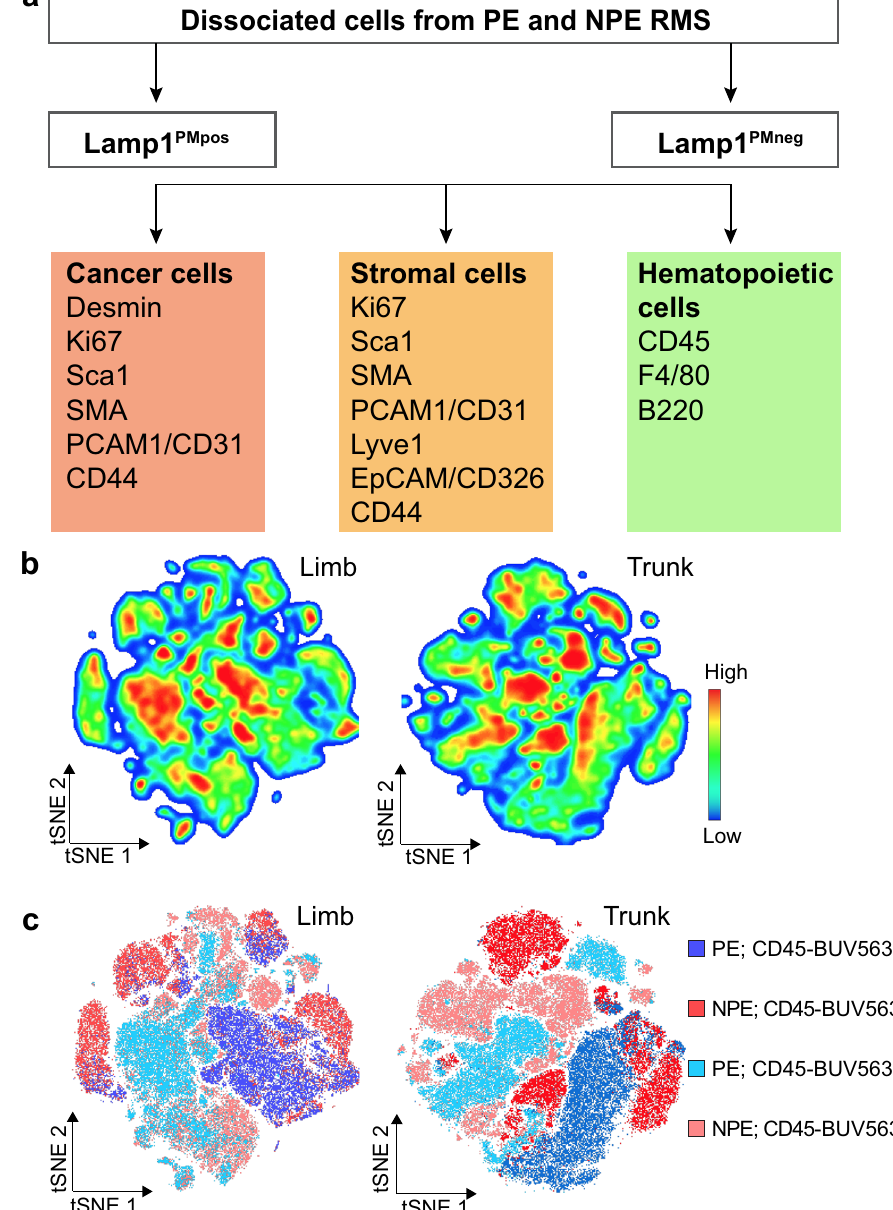
Fig. 4 Single-cell multiplex fl ow cytometry analysis identi fi es murine RMS cell heterogeneity. a Flow chart of multiplex fl ow cytometry analysis used to identify different cell populations in NPE and PE RMS. b tSNE density heatmaps of limb and trunk RMS from PE and NPE mice depicting areas of low and high cell number, based on the expression of the different markers (in a ). c tSNE graphs of limb and trunk RMS from PE and NPE mice indicating the distribution of CD45 neg and CD45 pos